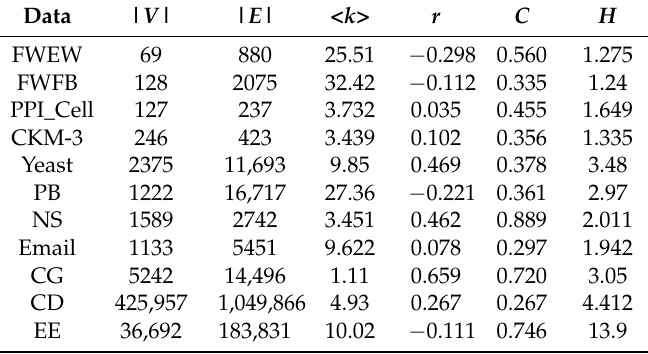
Table 5. Basic topological features of 6 example networks. | V | and | E | are the total numbers of nodes and links, respectively. < k > represents the average degree of nodes in a network. C and r are the clustering coefficient and assortative coefficient respectively. H is the degree heterogeneity, defined as H = < k 2 > < k > 2